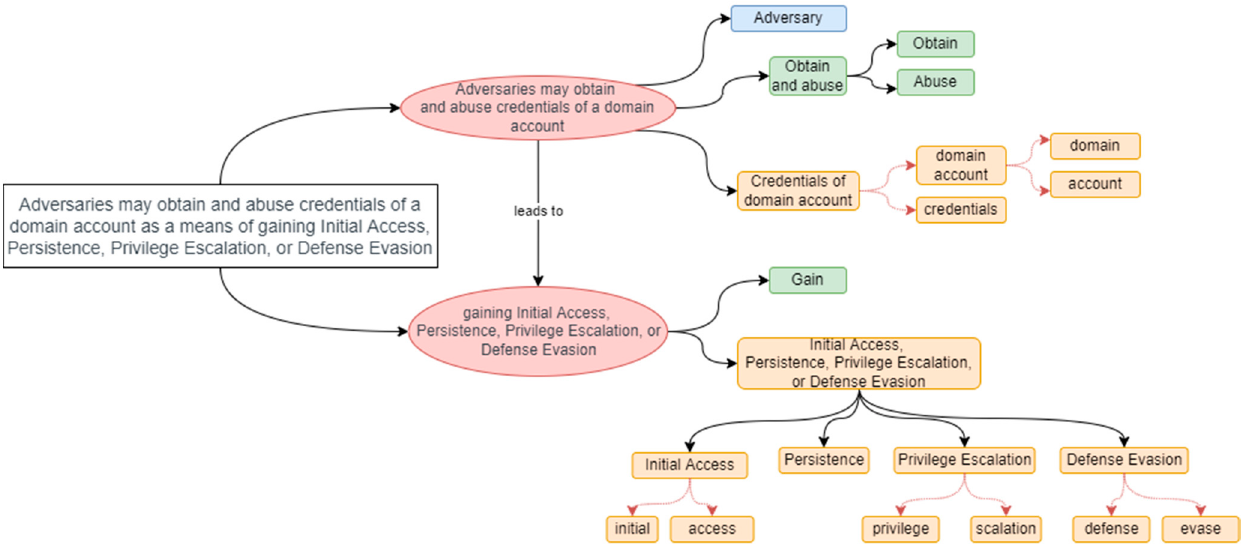
Figure 5. An example of sentence presentation as multiple atomic sentences, where each sentence is divided into subject, action, and object, as well as segmented to the lowest-granularity elements.